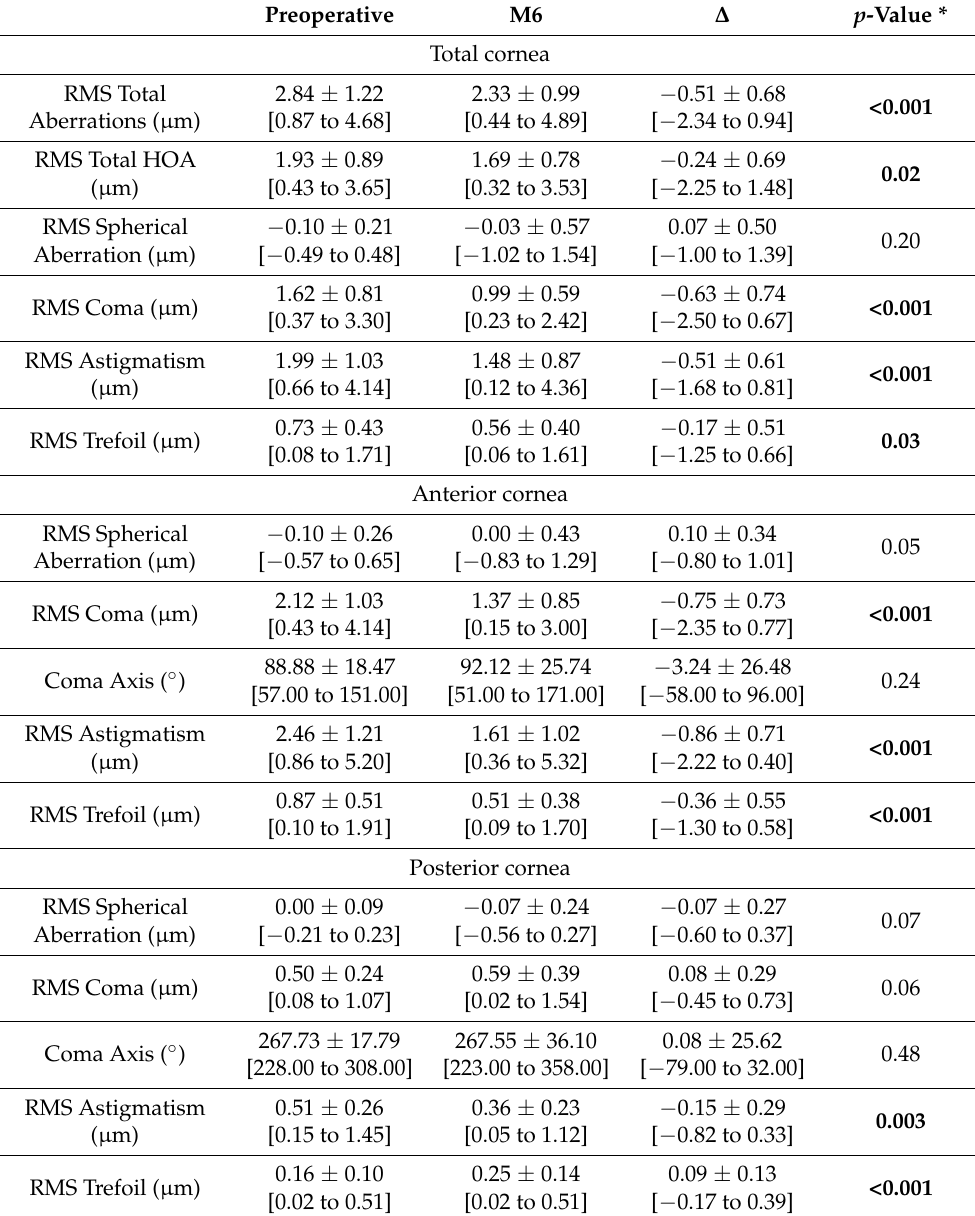
Table 6. Corneal aberrometry results ( n =